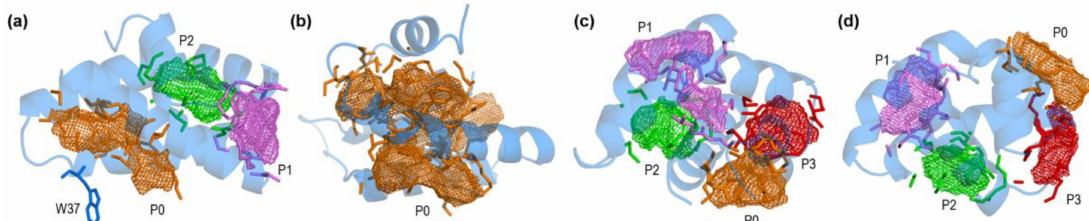
Figure 3. Surface pockets detected by DogSite in the closed conformations of human saposins. ( a ) Saposin A (chain A in 4UEX). ( b ) Modeled structure of saposin B ( c ) Saposin C (2GTG). ( d ) Saposin D (chain A in 2RB3). Mesh isosurfaces represent the pockets and their closer residues are depicted as sticks in the same color. Protruding W37 in saposin A (residue with an important role in the activity of this saposin: see below) is also drawn. Pocket numbering indicates their arrangement in order of decreasing volume (see Table